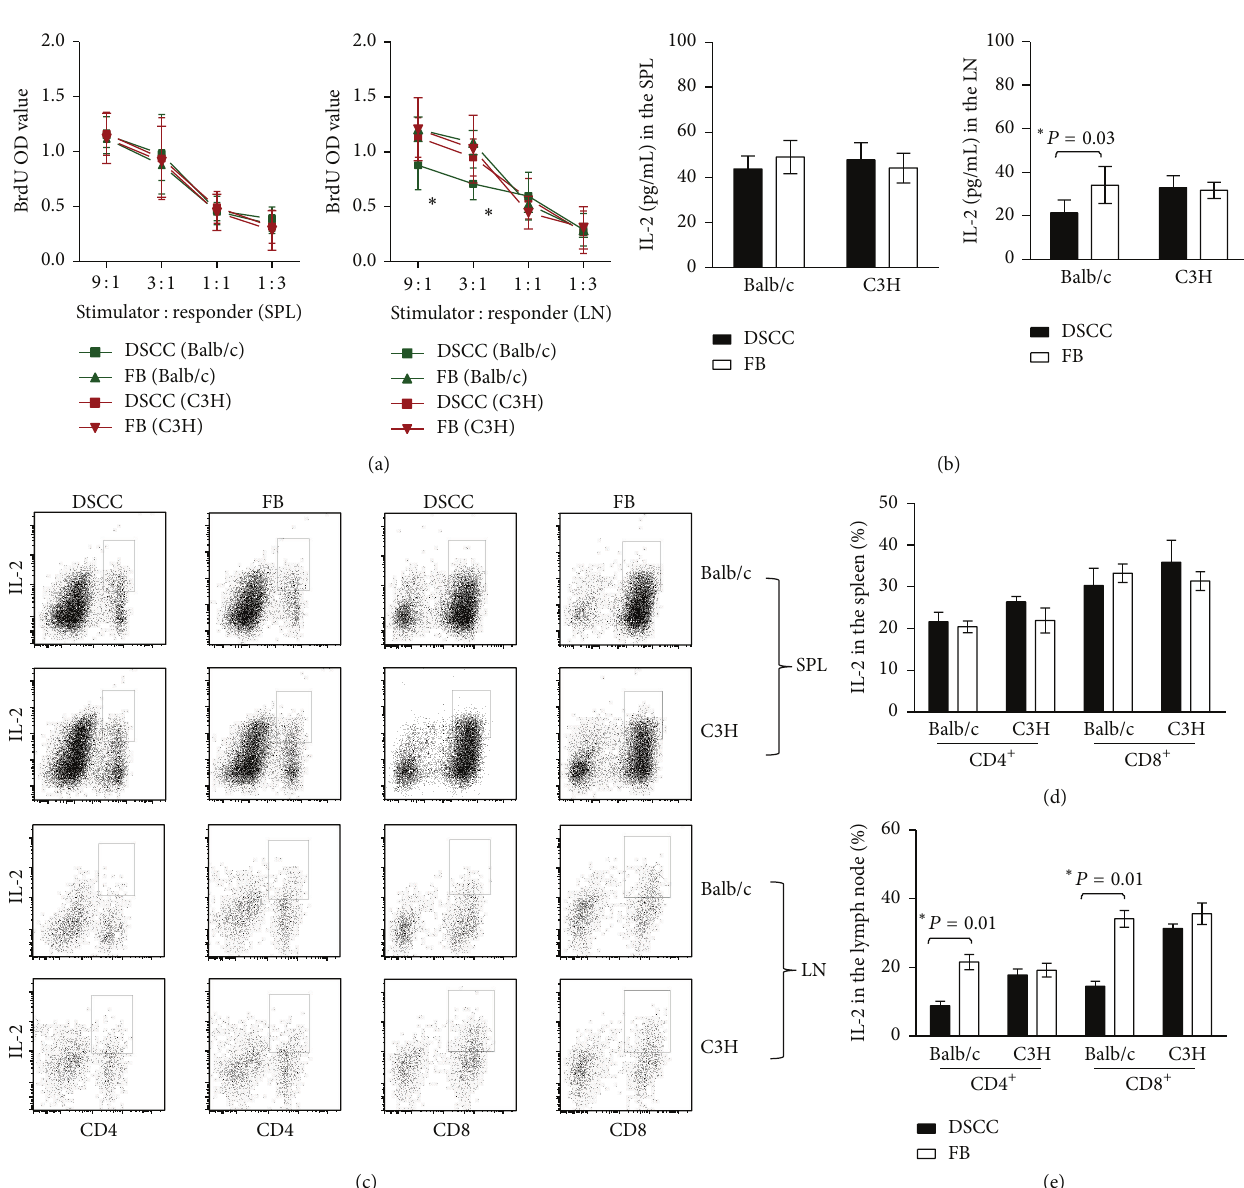
(e)0.00.51.01.52.0 Figure 6: DSCC protects transplanted islets without systemic immunosuppression. (a) Allogenic mixed-lymphocyte reaction (MLR) type assays of leukocytes from group 1 (DSCC) mice were compared with leukocytes from group 2 (FB) mice at week two after transplantation. The responses of the responders from group 1 (DSCC, square) and those of responders from group 2 (FB, triangle) B6 (H-2b) recipients to stimulator 𝛾 -irradiated-splenocytes (at 2500 rad) from Balb/c (left, H-2d) or C3H (right, H-2k, third party control) were tested at the indicated ratios after 4 days of incubation. Wells were pulsed with BrdU for the last day, and BrdU incorporation into DNA was measured in triplicates. There was no significant difference in the leukocyte responders from the spleen (left) or renal lymph nodes (right) of group 1 and group 2 mice in response to C3H derived splenocyte cell stimulation. ∗ Significant differences between groups 1 and 2 renal lymph node leukocytes, but not splenic leukocytes, at stimulator/responder ratios of 9: 1 ( 𝑃 < 0.04 ) and 3 : 1 ( 𝑃 < 0.01 , 𝑛 = 6 ) were noticed in response to Balb/c derived splenocyte stimulation. (b) The total amount of IL-2 secretion in the MLR culture was detected by ELISA and expressed in pg/mL. No significantly different IL-2 secretion was observed in response to C3H derived splenocyte cell stimulation in the two groups. Significant differences in IL-2 secretion were observed between groups 1 and 2 renal lymph node derived leukocyte cell cultures, but no difference was observed in spleen derived leukocytes in response to Balb/c derived splenocyte stimulation. (c) Representative dot plots of IL-2 production in CD4 + (left) or CD8 + (right) cells are presented from flow cytometric analysis. Accumulating data were calculated based on 3 independent experiments of 6 mice in total per group. (e) A significant decrease of IL-2 expression in both CD4 + and CD8 + subsets from renal lymph nodes from group 1 (DSCC) compared with group 2 (FB) was noticed in response to Balb/c but not C3H derived splenocytes. (d) No significant difference was identified in the spleen cells in response to either Balb/c or C3H splenocyte stimulation. Each dot represents one mouse. ∗ 𝑃 < 0.05